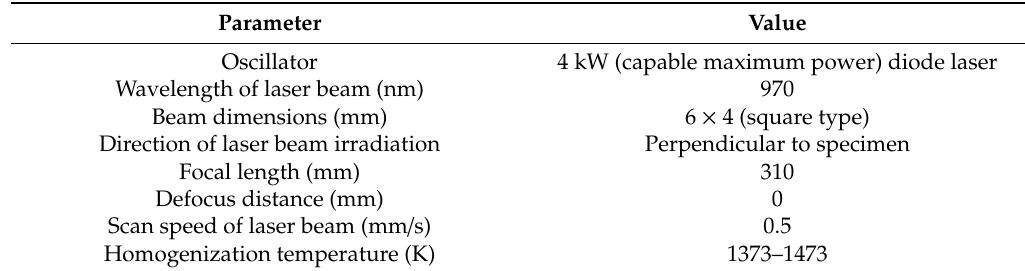
Table 3. Specification of equipment and conditions for laser surface heat